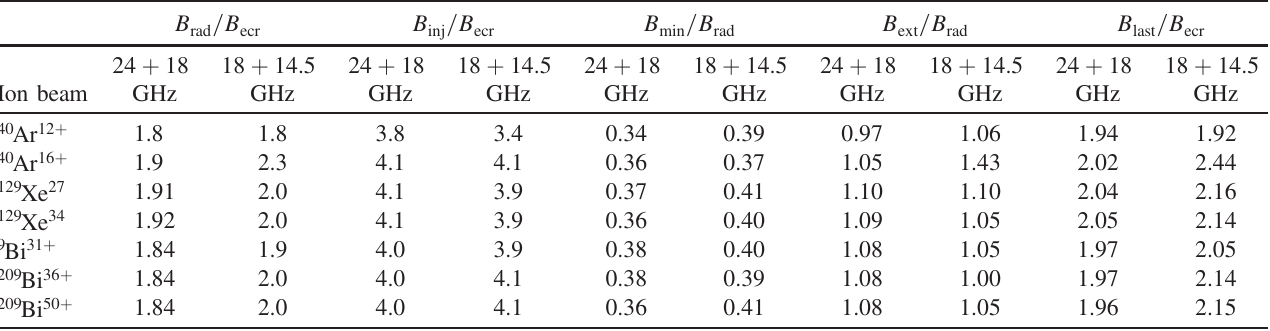
TABLE II. Ratios of those key magnetic field values B 24 þ 18 GHz double frequency heating to achieve the best beam intensities for